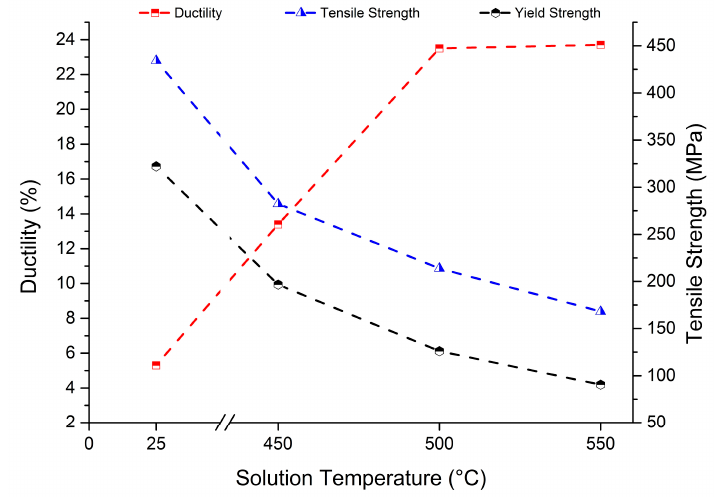
Figure 17. Tensile properties of AlSi10Mg alloy specimens produced by means of SLM, as-built and after solution heat treatments at different temperatures. The post process solution heat treatment was conducted for 2 h and was followed by water quenching at room temperature.